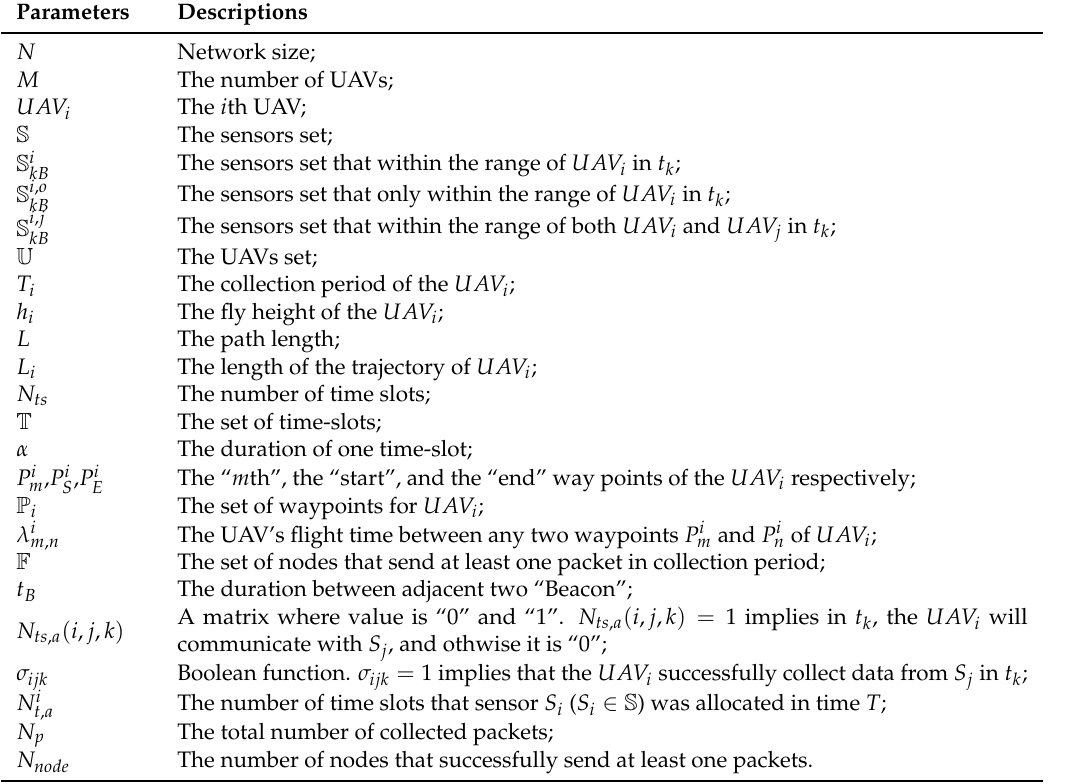
Table 2. Major notations used in this article.